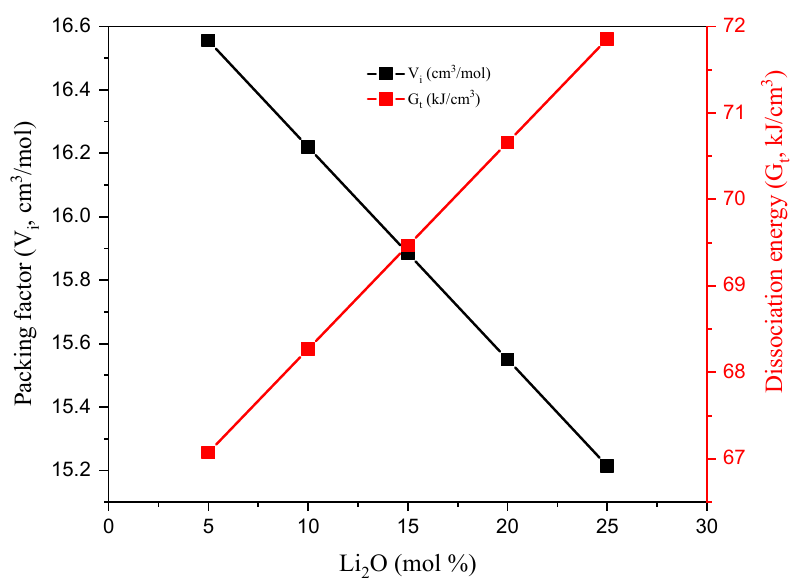
Figure 3. The investigated glasses’ dissociation energy and packing factor versus the Li 2 O concentration. The TABLi glasses’ packing density (V t ) was reported based on the predicted V i values. V t ’s calculated values were 0.567 to 0.630, raising the ratio of Li ions in the glass network. The elastic moduli (Y, K, B, and L) were reported for the investigated samples. Clearly, Y’s modulus decreased by increasing the V i values. But it is enhanced by increasing the G t of the TABLi glasses, as shown in Figure 4. This is due to the substitution of weak Ti-O bonds by strong Li-O bonds. Additionally, Y’s values enhanced from 80.120 to 90.579 GPa by raising the Li 2 O between 5 and 25 mol%, respectively. The other moduli K, B, and L’s values follow the same trend as Y when the Li 2 O increases between 5 and 25 mol%.